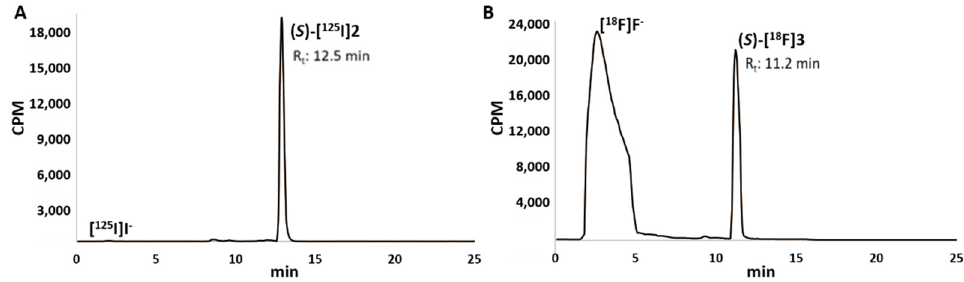
Figure 5. Radioactivity-HPLC chromatograms of the crude reaction mixture of the radioiodination ( A ) and radiofluorination ( B ) from precursor ( S )- 15 .